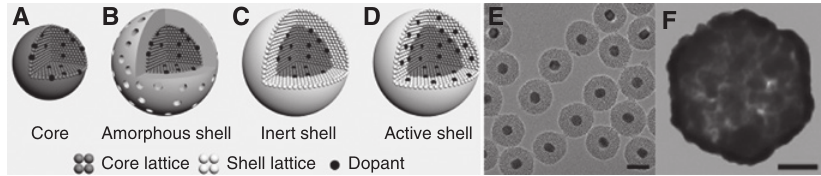
Figure 9: Different strategies to enhance the luminescence of UCNPs: Schematic illustration of a dye-sensitized UCNP: (A) Lanthanide- doped core NP. (B) Amorphous shell coating. (C) Inert crystalline shell coating. (D) Active-shell design with sensitizers or activators doped in the shell layer. Taken from [199]. Reproduced with permission of John Wiley and Sons. Copyright © 2014. (E) Porous silica coating on NaYF :Yb 3 + , Er 3 + @NaGdF :Yb 3 + NPs. Bar = 50 nm. Taken from [164]. Reproduced with permission of John Wiley and Sons. Copyright © 2013. 4 4 (F) NaYF :Yb 3 + , Tm 3 + nanocrystals coated with a Au nanoshell. Bar = 50 nm. Taken from [231]. Reproduced with permission of John Wiley and 4 Sons. Copyright ©